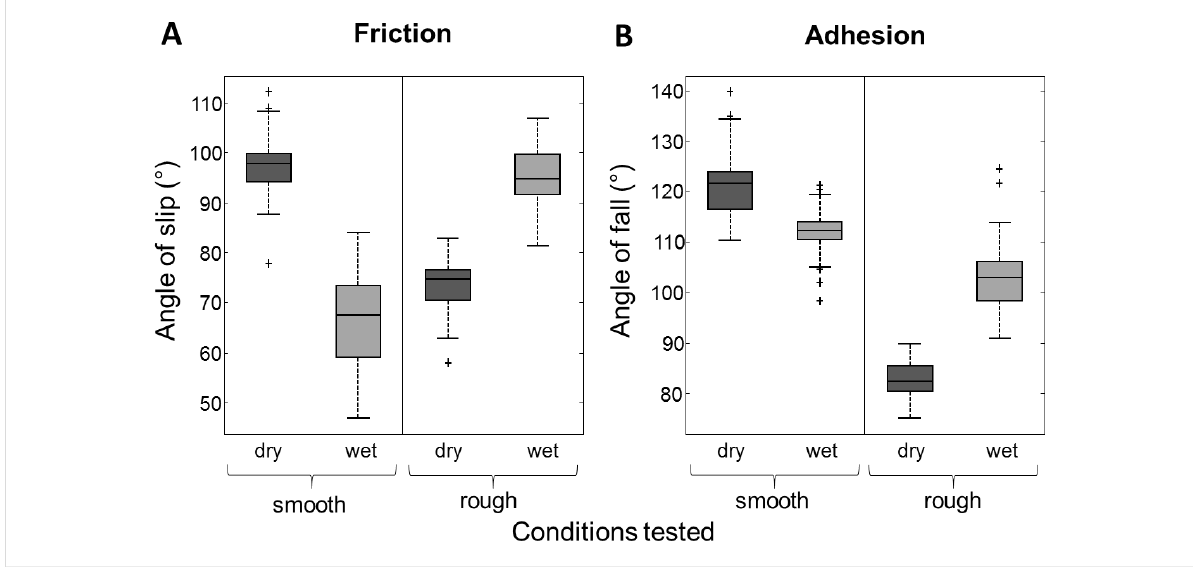
Figure 7: Boxplots displaying attachment performance of tree frogs in varying conditions. The angles of slip (A) and fall (B) of the frogs are shown for dry and wet surfaces, which could also be either rough or smooth.